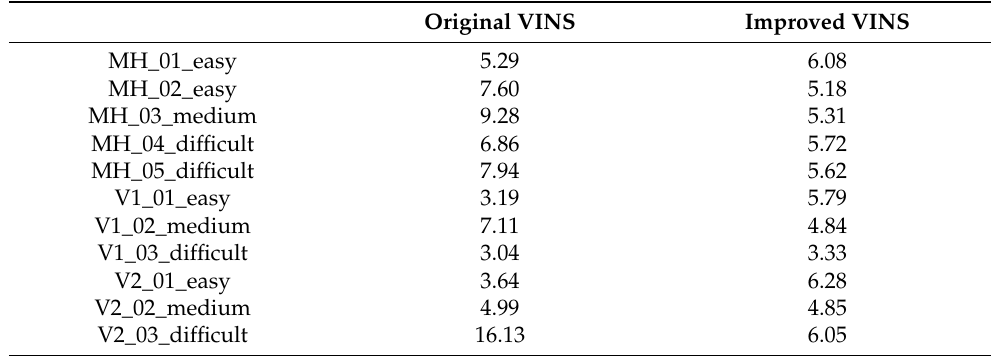
Table 5. The feature extraction speed of the original algorithm is compared with that of the improved algorithm in the EuRoC dataset. (Unit: